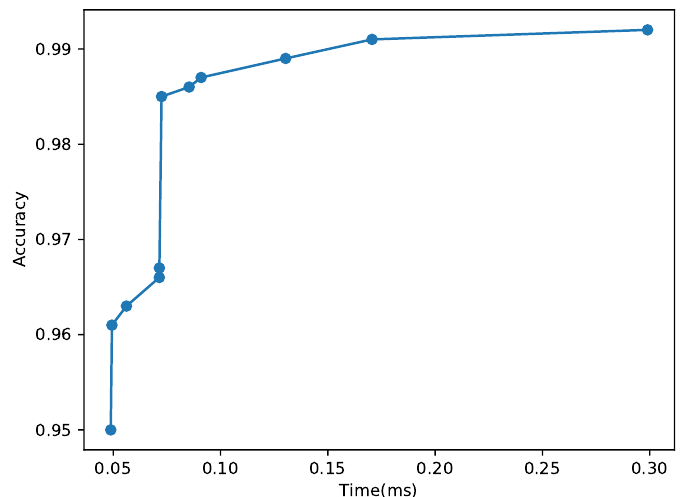
Figure 14. Pareto Optimal CNNs for MNIST. As illustrated in this figure, the set H P that consists of Pareto optimal CNNs may include several models with similar execution times and accuracy. Thus, it is necessary to select δ -Pareto CNNs only and include them in H δ P to meet user requirements in a cost-efficient